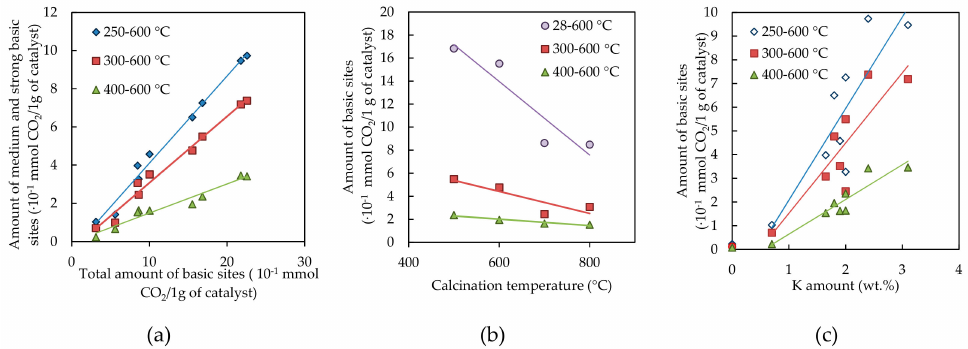
Figure 6. TPD CO 2 results: ( a ) Dependence of the amount of medium and strong basic sites on the total amount of basic sites in temperature range of 0–600 ◦ C, ( b ) dependence of the amount of basic sites on the calcination temperature and ( c ) dependence of the amount of basic sites on the potassium amount. Numbers in legend mean temperature region from which the amount of sites was calculated.